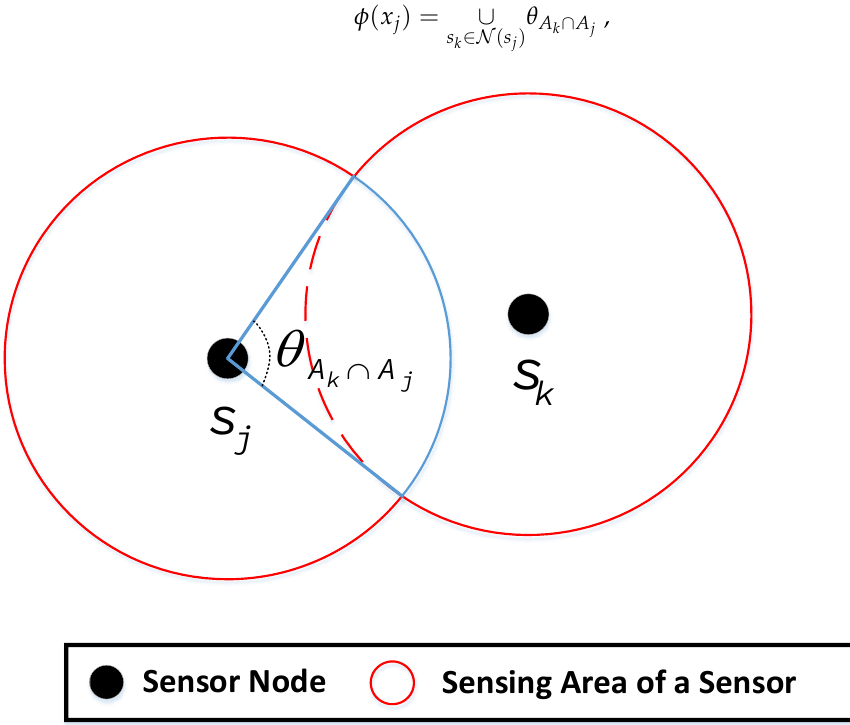
Figure 7. The overlap of the sensing area of two nodes.